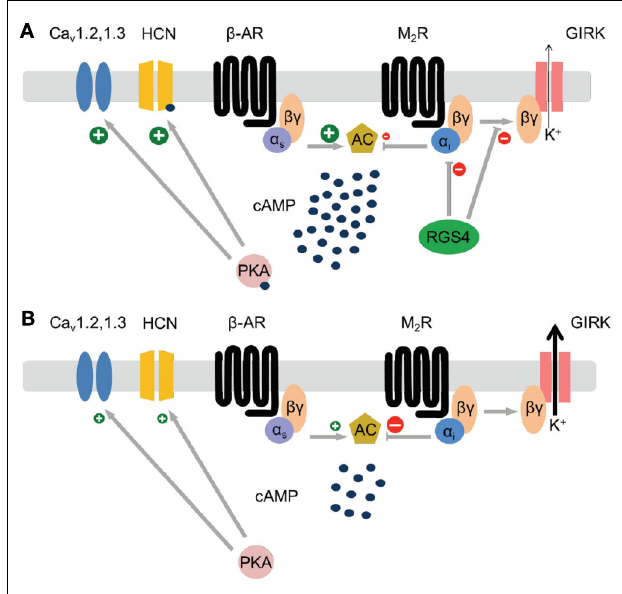
FIGURE 1 | Modeling parasympathetic signaling pathways in pacemaker cells of the SAN in the presence (A) and absence (B) of RGS4 function. Note the potential for RGS4 to act as a master upstream regulator of the primary effectors of the M2 muscarinic receptor (GIRK channels, and adenylyl cyclase). (A) In the model where RGS4 is functional, G α i signaling is attenuated resulting in decreased GIRK channel activity and increased cAMP concentrations that can directly stimulate increased HCN4 channel activity and indirectly (via PKA activation) increases Ca V channel activity. (B) In the model where RGS4 function is absent G α i signaling is increased resulting in increased GIRK channel activity and decreased cAMP concentrations.This condition is expected to result in lower HCN4 and Ca V channel